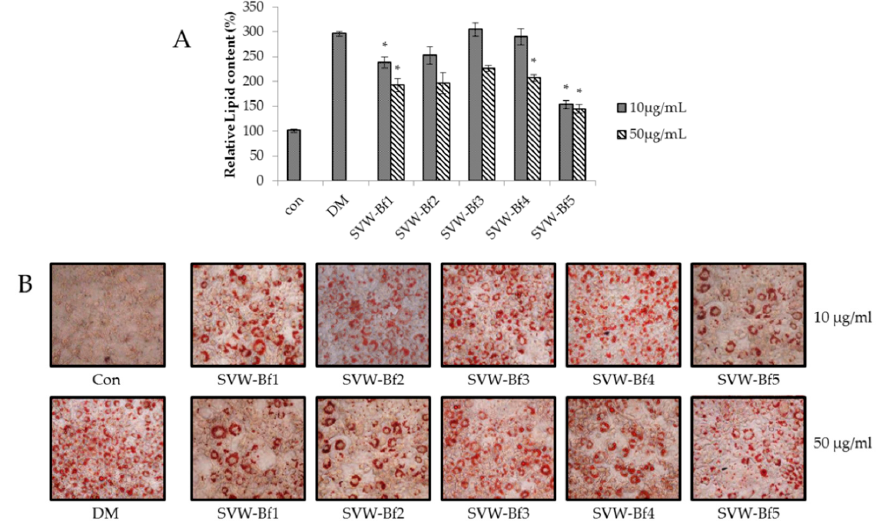
Figure 4. Effect of Diaion HP-20 fractions of SVW-Bf in 3T3-L1. ( A ) The relative lipid content; ( B ) Oil Red O staining images. Confluent 3T3-L1 preadipocytes were differentiated into adipocytes in medium with or without different concentrations of SVW-Bf Diaion HP-20 fractions for 8 days. Three independent experiments have been carried out; * p < 0.05 vs. DM.